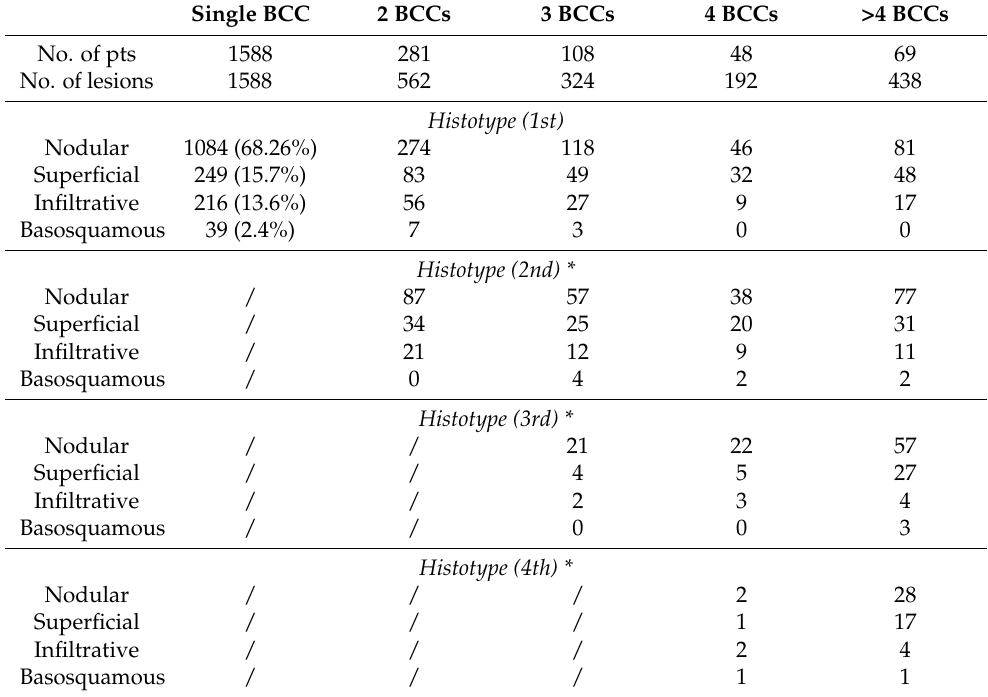
Table 4. Histopathological features of patients with single or multiple BCCs. Single BCC 2